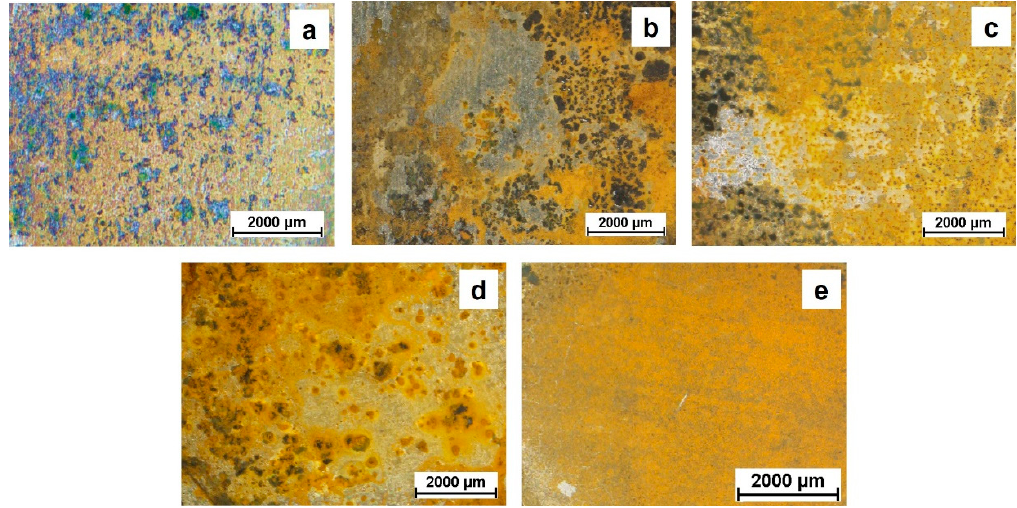
Figure 9. Visual appearance of the investigated samples after one week (168 h) of immersion in the 0.1 M NaCl solution: ( a ) PSZ-10, ( b ) PSZ-20, ( c ) PSZ-30, ( d ) PSZ-40, and ( e ) bare